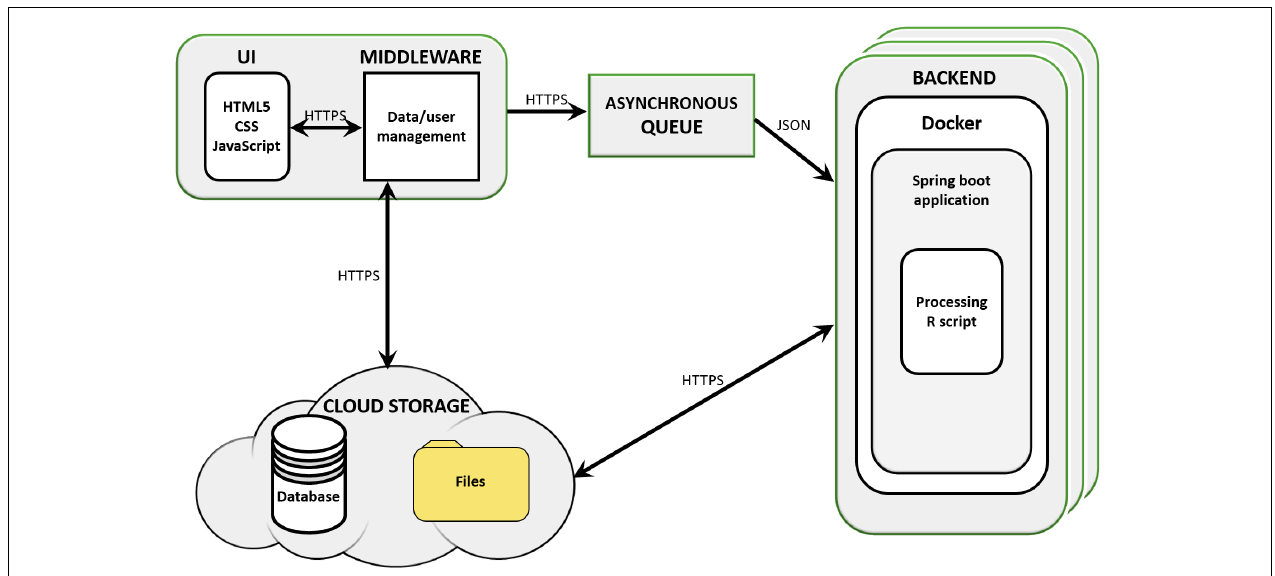
FIGURE 1 | Simplicity ’s cloud-based structure. Simplicity is available on-line and presents a user interface (UI) that carries out real-time processing through its middleware storage and scripts. User requests are managed by an asynchronous queue and data is passed to cloud storage. Once a processing node is available, the backend retrieves the analysis parameters and data from the cloud storage and analyses it, delivering results to the user and compiling reports and interactive visualizations in the